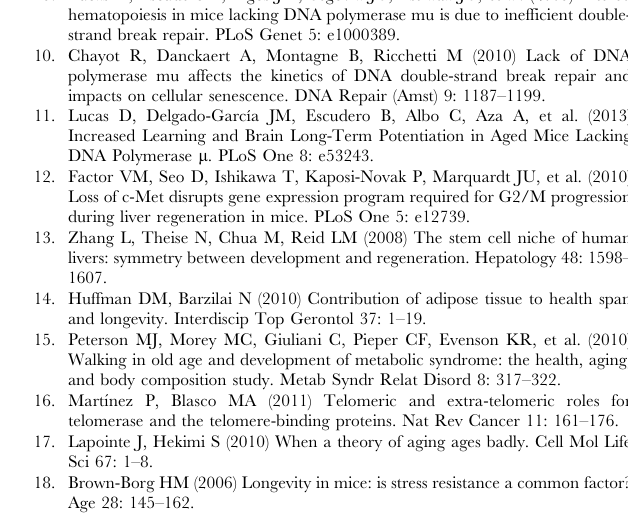
Figure S5 Evaluation of SCE in Pol m 2 / 2 cells.